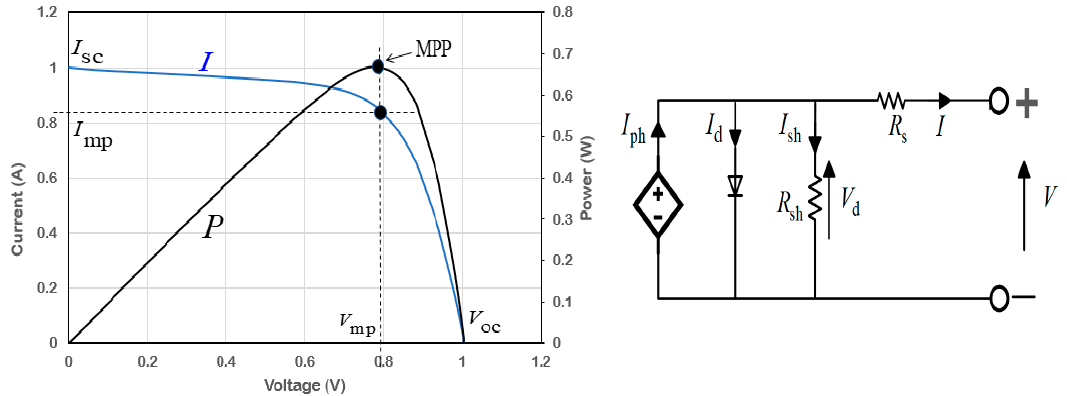
Figure 1. The normalized I-V and P-V curves of a typical PV module ( left ) and the single-diode model ( right ) .